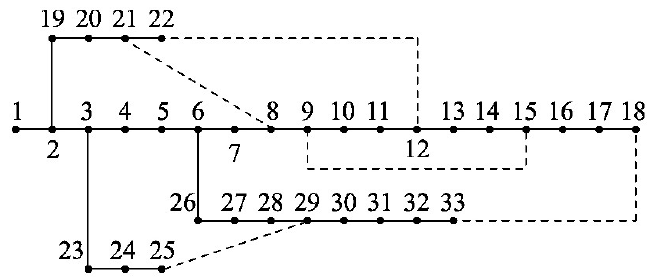
Figure 14. Single line diagram for the IEEE 33-bus system.